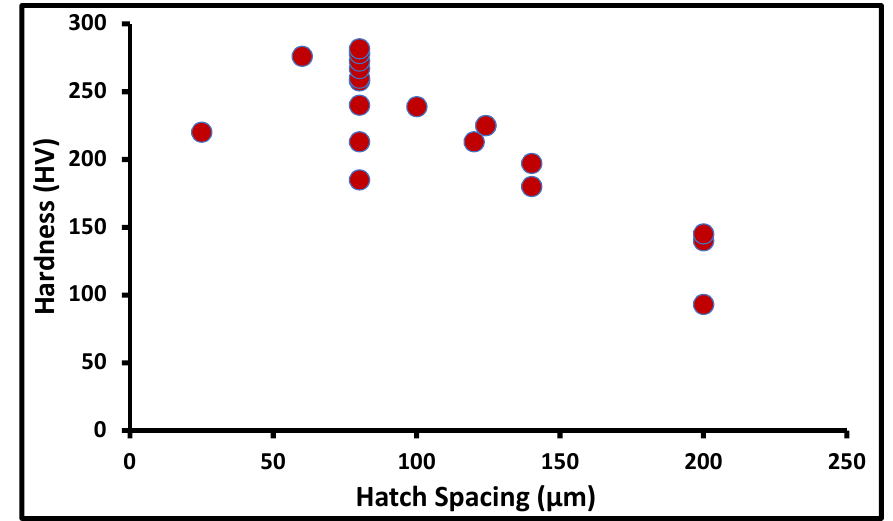
Figure 5. Hardness at varied hatch spacing.